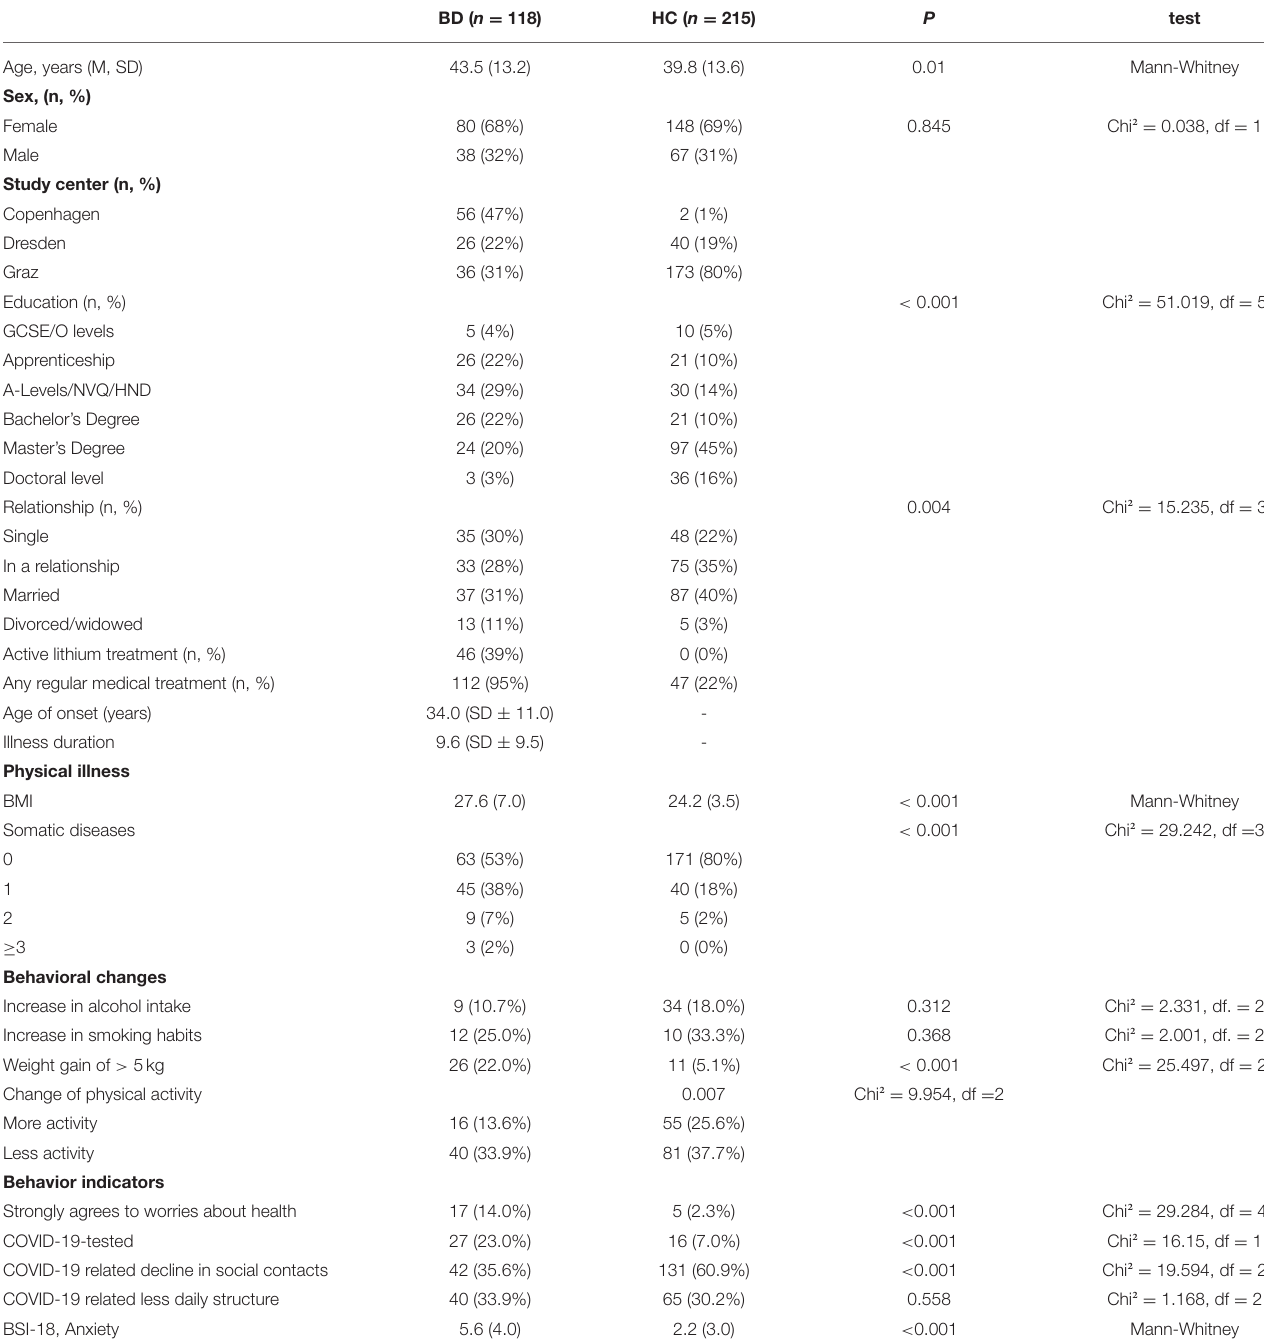
TABLE 1 | Sociodemographic characteristics, physical health status, COVID-19 behavioral changes, and anxiety scores in patients with bipolar disorder (BD) and healthy control individuals (HC), mean (M) and in brackets standard deviation